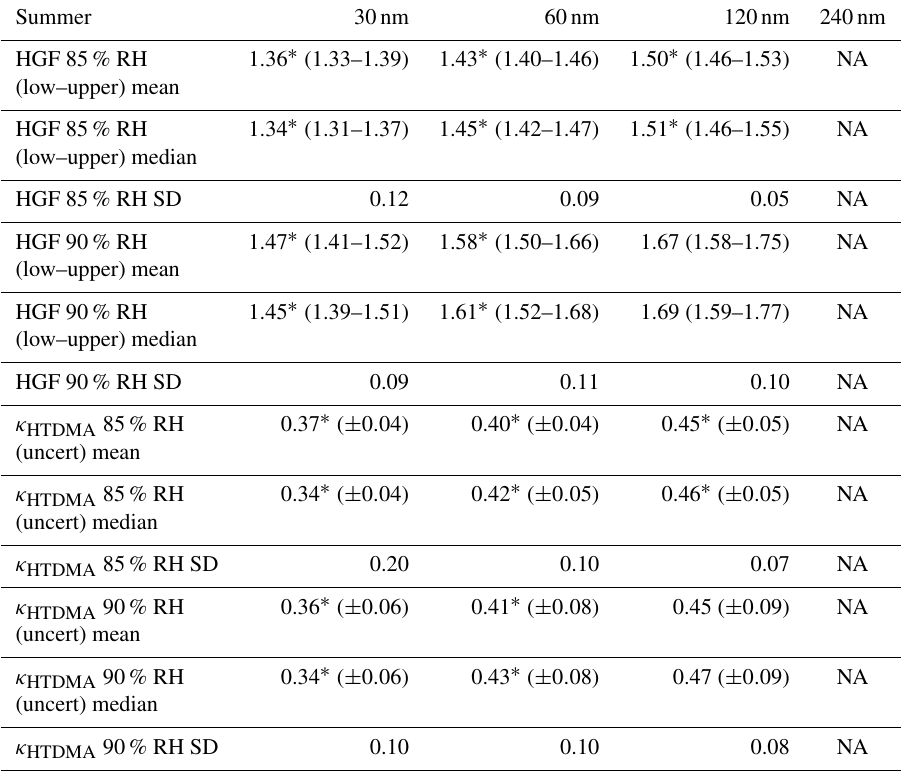
Table 5. Statistics of HTDMA measurements during the summer field study. The stated uncertainties are the respective statistics of the associated uncertainty retrieved from the fitting procedure as described in Sect. 2.5. The values of SD are the standard deviations of the parameter distributions over the temporal evolution of the studies. The asterisk ( ∗ ) signifies a significant difference between spring and summer field studies (Wilcoxon rank sum test, p < 0 . 05); there are no measurements at 240nm Dp dry for the summer field study. HTDMA measurements for the summer field study were obtained from 15 August to 28